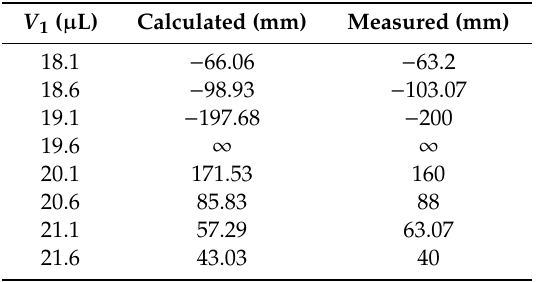
Figure 10. Captured images using a resolution target. ( a ) When no water is injected into the UTL, the image height of the resolution target y ′ 0 is obtained. ( b )–( i ) Changing the volume of injected water in LFL1 to change the focal length of the UTL. Table 2. Comparisons between the measured and calculated